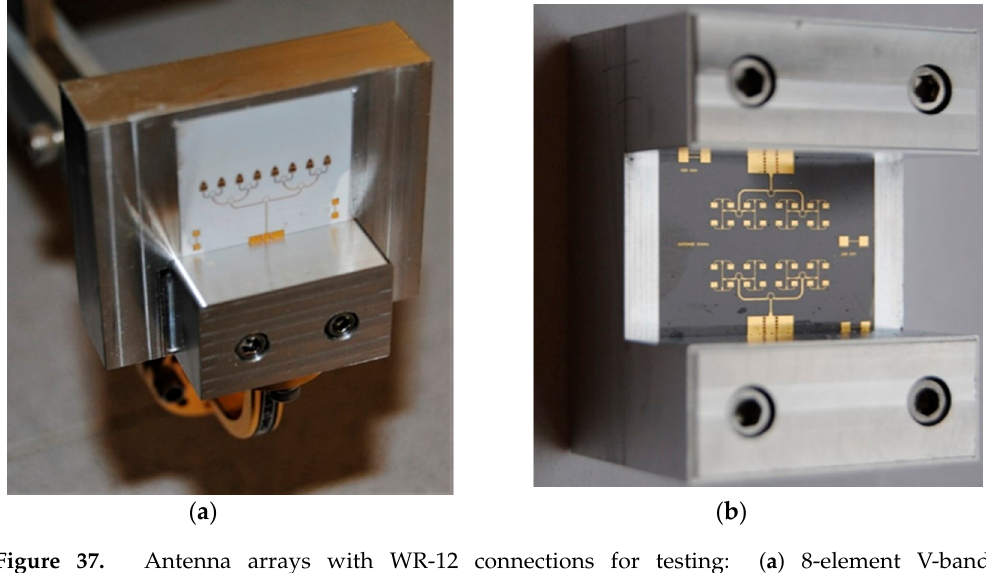
Figure 37. Antenna arrays with WR-12 connections for testing: ( a ) 8-element V-band; ( b ) 16-element W-band.